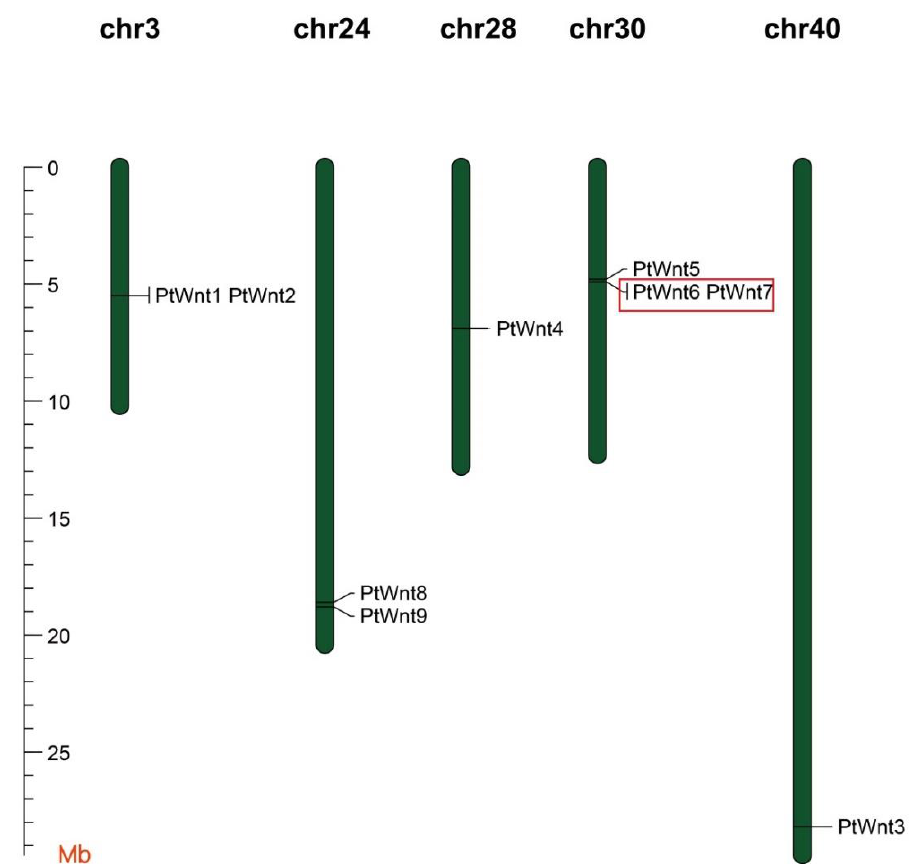
Figure 5. Chromosomal location and duplication events of nine Wnt genes on five different chromosomes of P. trituberculatus . Each chromosome number is indicated on the top of the chromosome bar. The scale of the chromosome is in millions of bases (Mb) (The length of green represents the number of bases). Each PtWnt gene is indicated on the exact position of a particular chromosome that can be calculated by using the scale provided on the left. Tandem duplicated genes are indicated by red boxes.